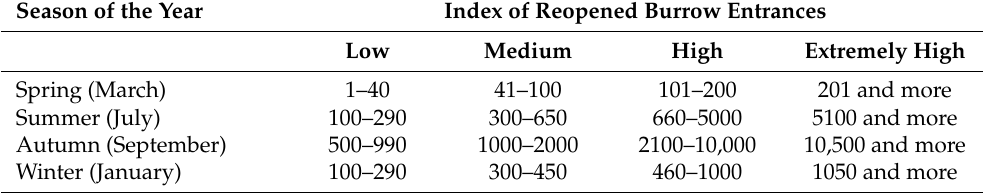
Table 4. Modified density categories of the common vole in 1968–1970, according to a new evaluation. The norm [71] was replaced by a modified norm, effective from 1 March 1983 [2].